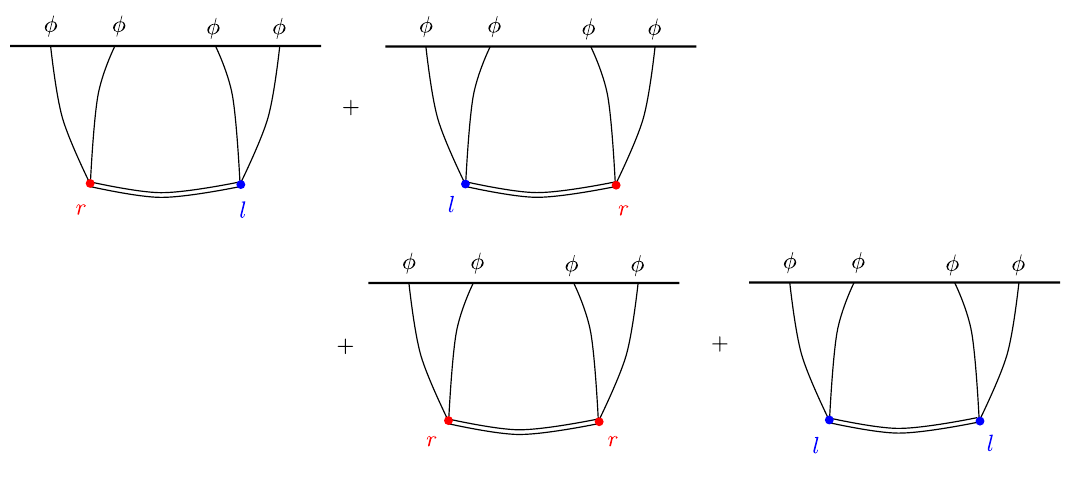
Figure 18 . Exchange diagrams with the “full” propagator of the σ particle, see figure 17. The analytic structure of the four-point function is richer after the resummation, see section 6.4, and going to the resonance at ν = ν σ we get a non-trivial check of the positivity constraint, see section